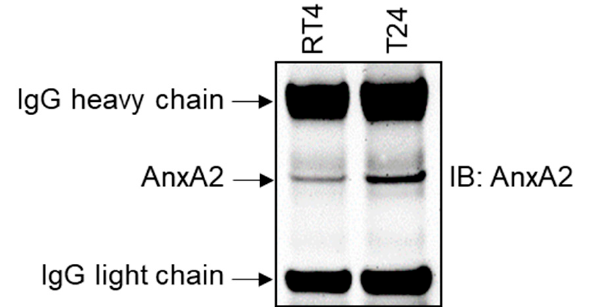
Figure 5. AnxA2 secretion from bladder cancer cell lines. The RT4 or T24 cells (2.5 × 10 6 ) were plated in a 100 mm Petri dish overnight and then replaced with a serum-free medium. AnxA2 protein was immunoprecipitated from the serum-free medium after 24 h incubation using an anti-AnxA2 antibody (BD Biosciences #610069). The amount of secreted AnxA2 in the medium was analyzed by immunoblotting using an anti-AnxA2 antibody. Uncropped Western Blot is available in File S1.